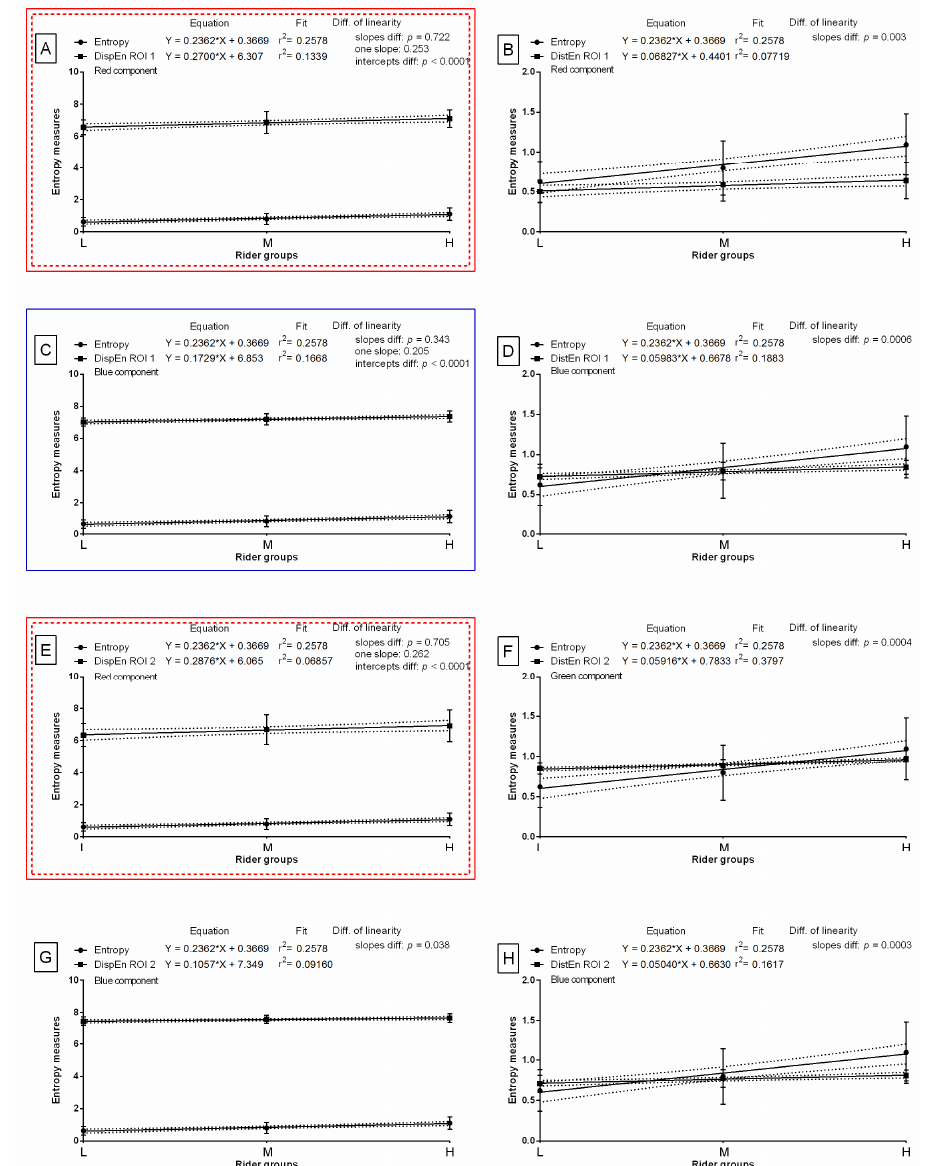
Figure 8. Comparison of studied entropy measures (DispEn—two-dimensional dispersion entropy, DistEn—two-dimensional distribution entropy) and selected gray-level run-length matrix feature (entropy) for examined color components (red, ( A , B , E ); green, ( F ); blue, ( C , D , G , H )), which were found to be significantly different between light (L), moderate (M), and heavy (H) rider groups on the post-exercise imaging. Data were presented separately for the withers area (ROI 1) ( A – D ) and the thoracic spine area (ROI 2) ( E – H ). Similarity was tested using linear regressions. A p -value of less than 0.05 was considered significant. If the difference between slopes was not significant, a single slope measurement was calculated. Plots with the entropy measures and slopes that did not differ with entropy were marked by colored (red, blue) solid frames. Plots with the entropy measures and slope values that were higher than entropy were marked by colored (red, blue) dashed